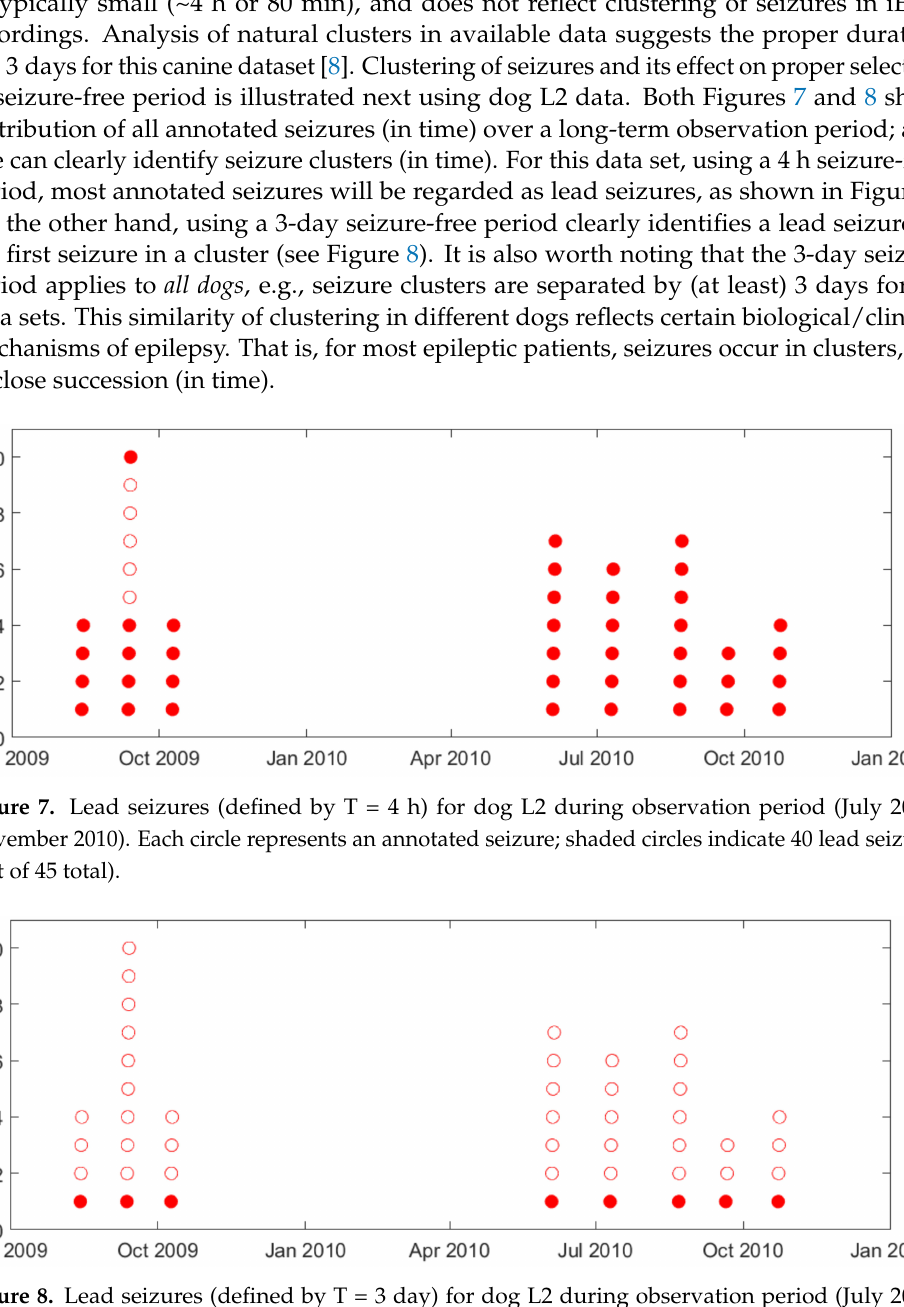
Figure 8. Lead seizures (defined by T = 3 day) for dog L2 during observation period (July 2009– November 2010). Each circle represents an annotated seizure; shaded circles indicate 8 lead seizures (out of 45